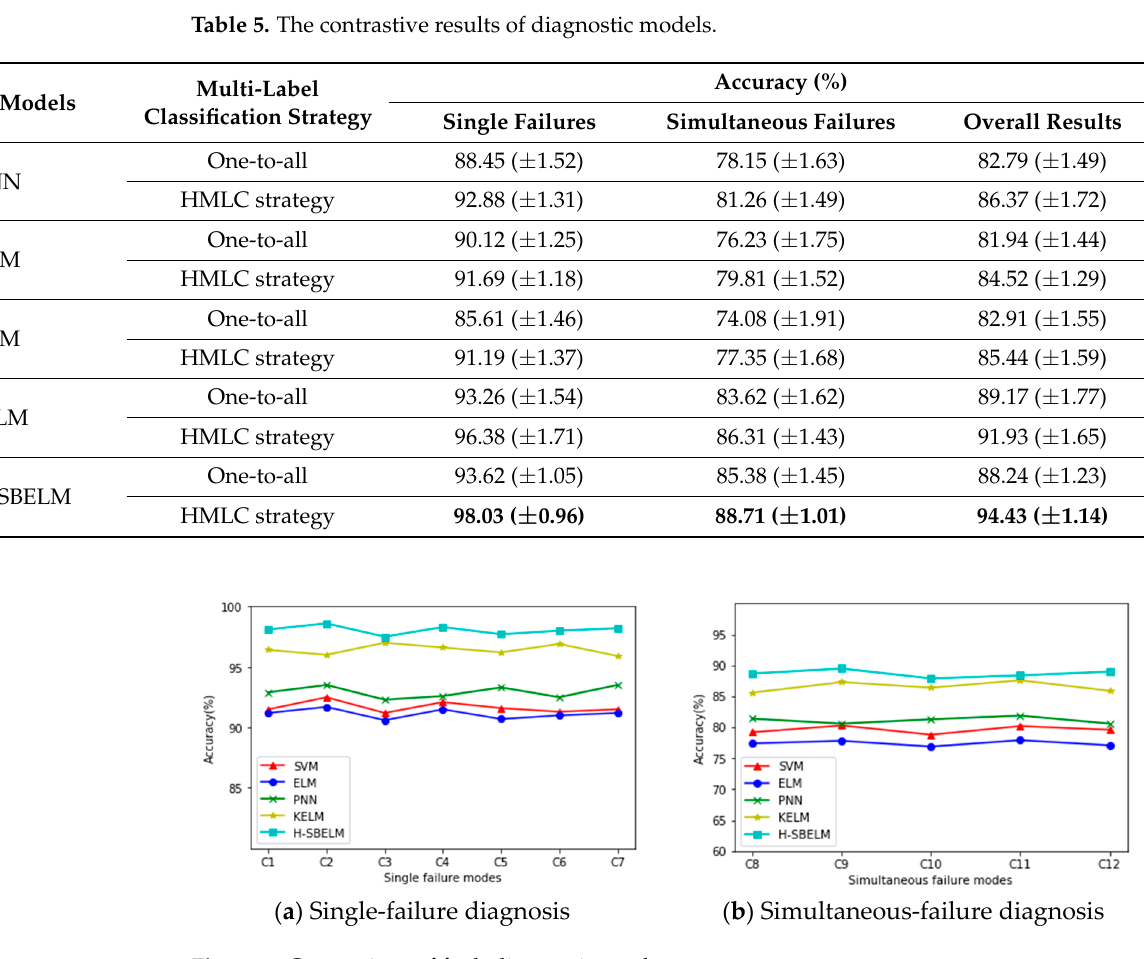
Figure 9. Comparison of fault diagnostic result.